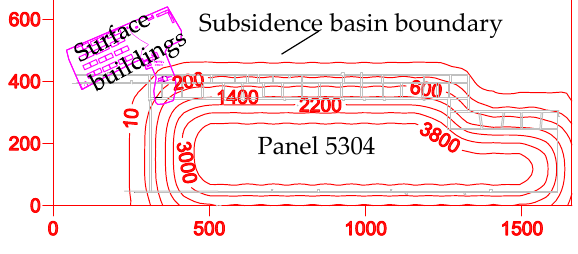
Figure 13. Surface subsidence contour line.